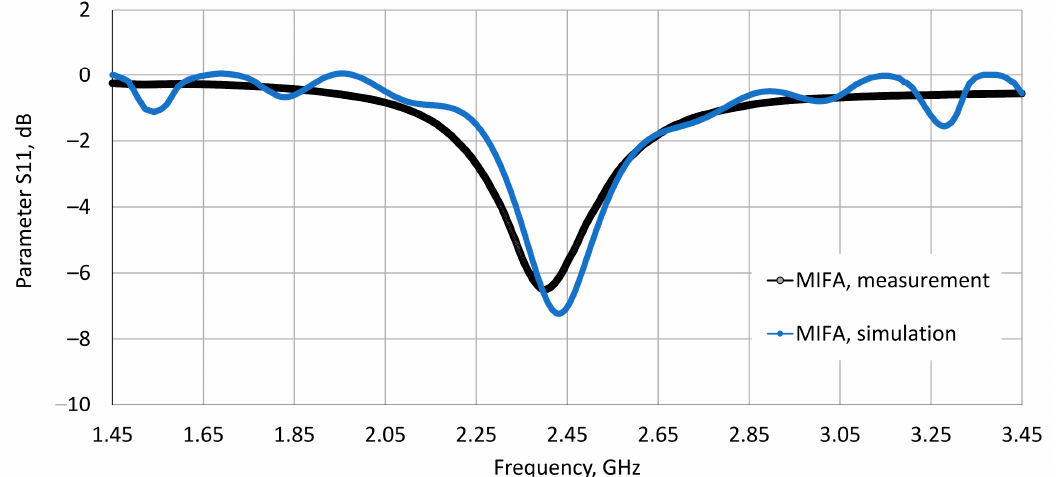
Figure 7. The S11 parameter, measured from the wireless communication module (the ESP32-WROOM-32 RF module) in the laboratory and determined using numerical simulations of the developed numerical model of the MIFA, used in the considered IoT wearable devices.